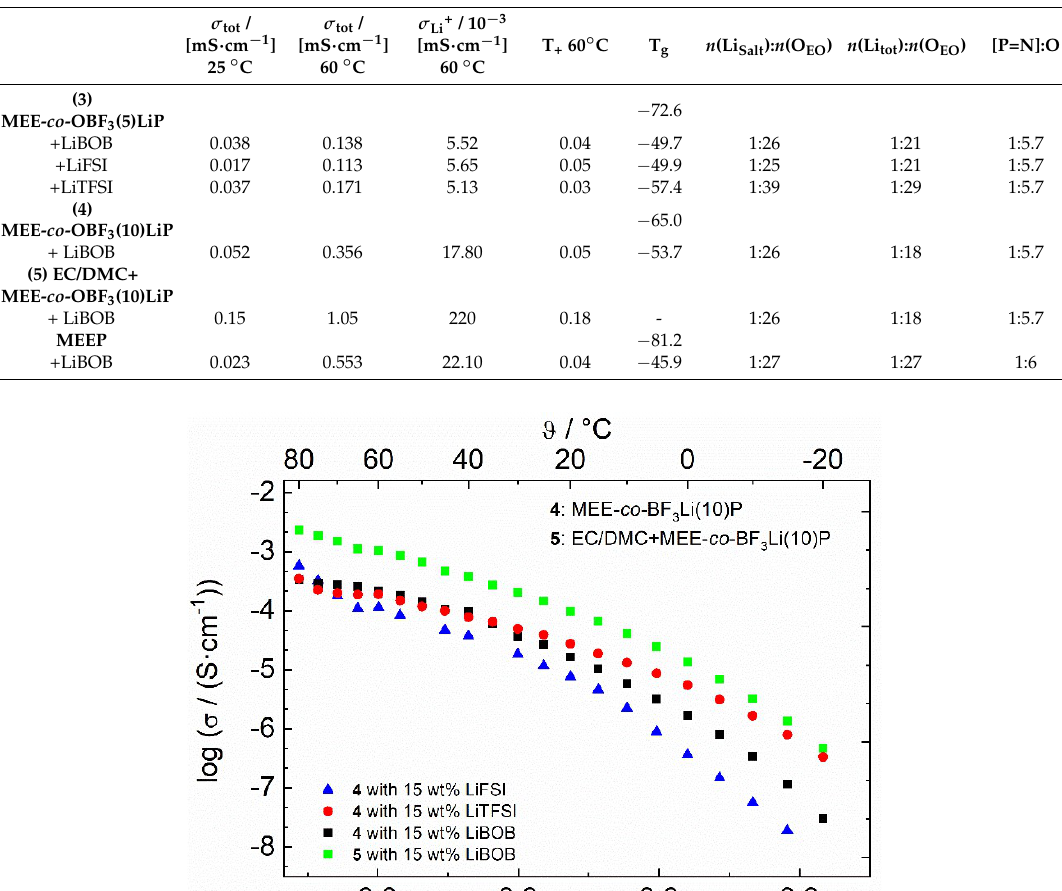
Figure 3. DSC Measurements of MEEP, MEE- co -OBF 3 Li(5)P, and MEE- co -OBF 3 Li(10)P.